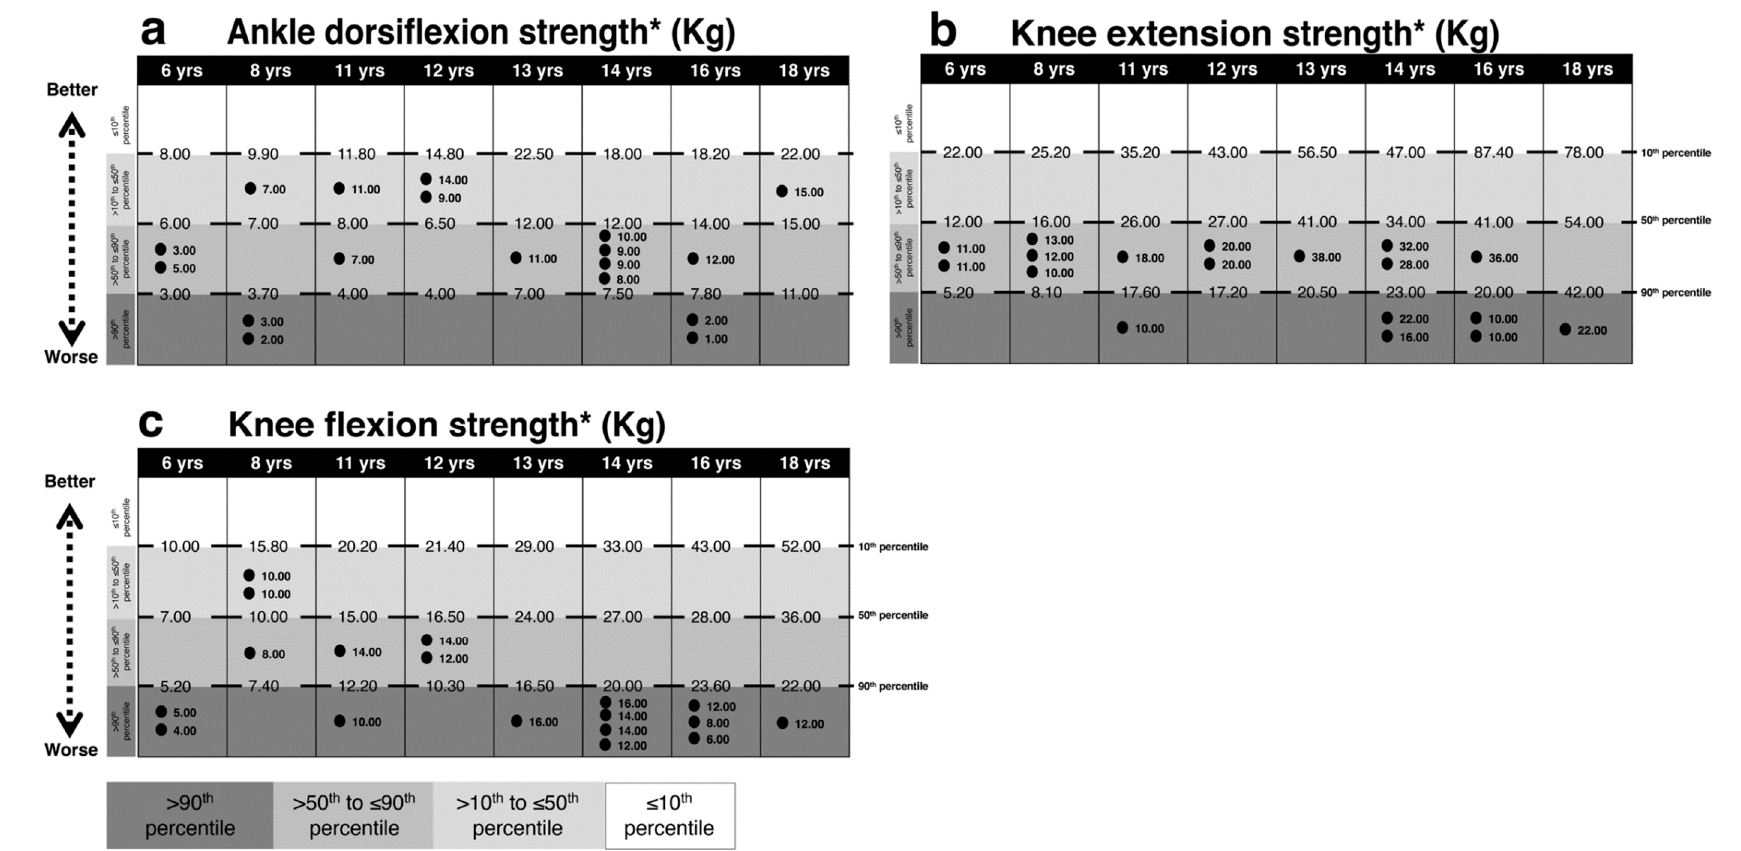
Figure 3. Comparison between each ASD subject’s performance in the PPA tests of lower limb strength and age-matched reference values (percentiles) for TD subjects. Light gray to dark gray corresponds with better to worse performance. In ( a ) ankle dorsiflexion force, in ( b ) knee extension force, in ( c ) knee flexion force. The reference value of the 10th, 50th and 90th percentiles and each ASD subject values are reported. Intervals for each performance represent: ≤ 10th, 10th < x ≤ 50th, 50th < x ≤ 90th, >90th percentile from the top to the bottom, respectively. * indicates the percentile scale was inverted, i.e., for all items a score over the 90th percentile is an indicator of a worse performance. Abbreviations: yrs, years; kg, kilograms.